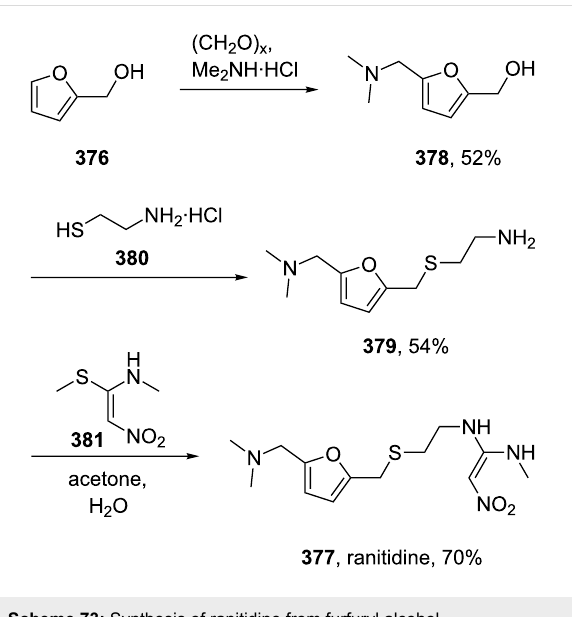
2-Furoic acid ( 375 ) can be obtained via a Cannizzaro-type disproportionation of furfural ( 374 ) which is industrially produced from corncobs: Annual production ca. 450,000 tons. Corncobs contain hemicelluloses which degrade to xylose under acidic conditions. Upon strong heating, xylose is converted to furfural, which can be distilled from the biomass (Scheme 72).